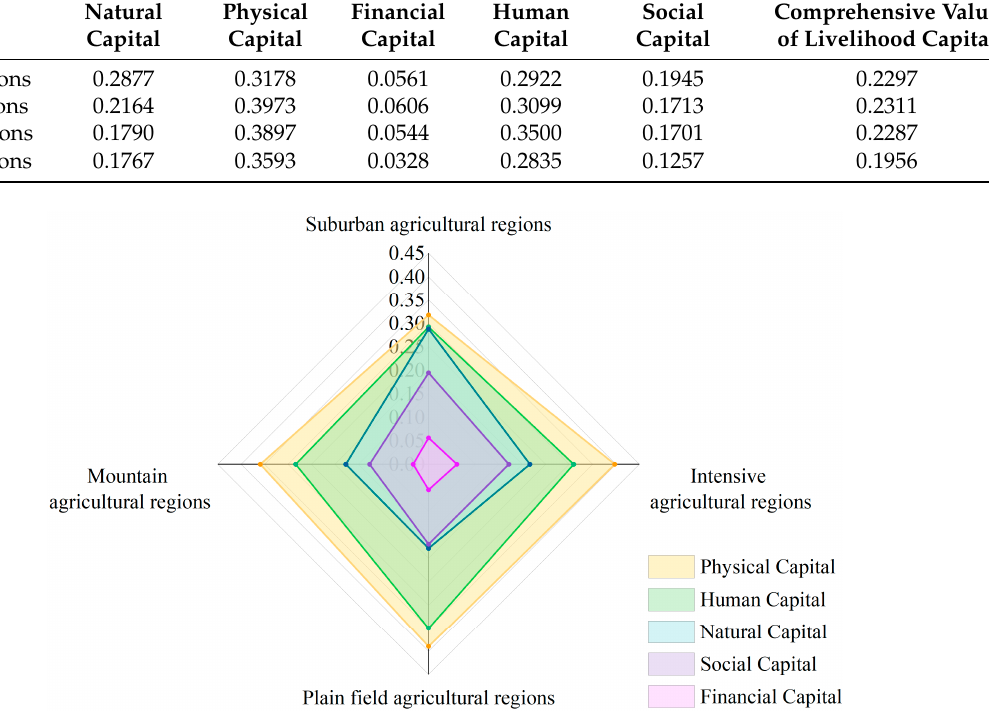
Figure 2. Comparison of sub-item livelihood capital per household in different agricultural regions.